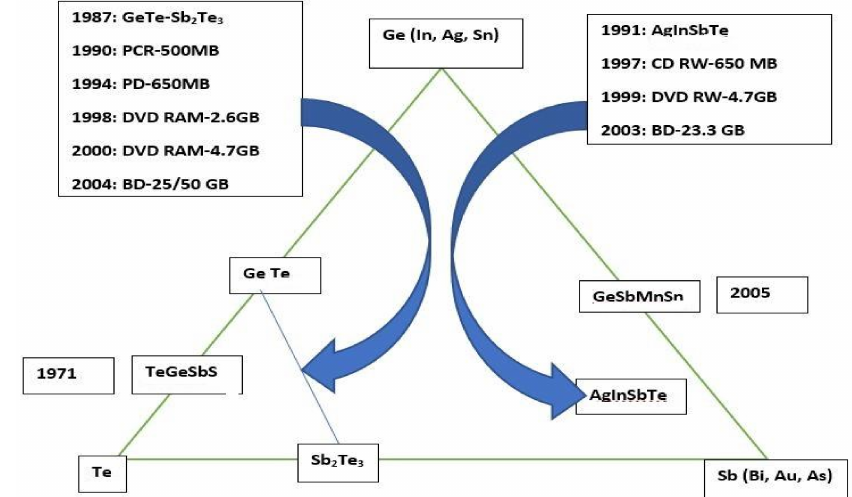
Figure 2. Ternary phase diagram showing the different possible alloys and the year of discovery and commercialization of phase change materials (PCM) in optical storage